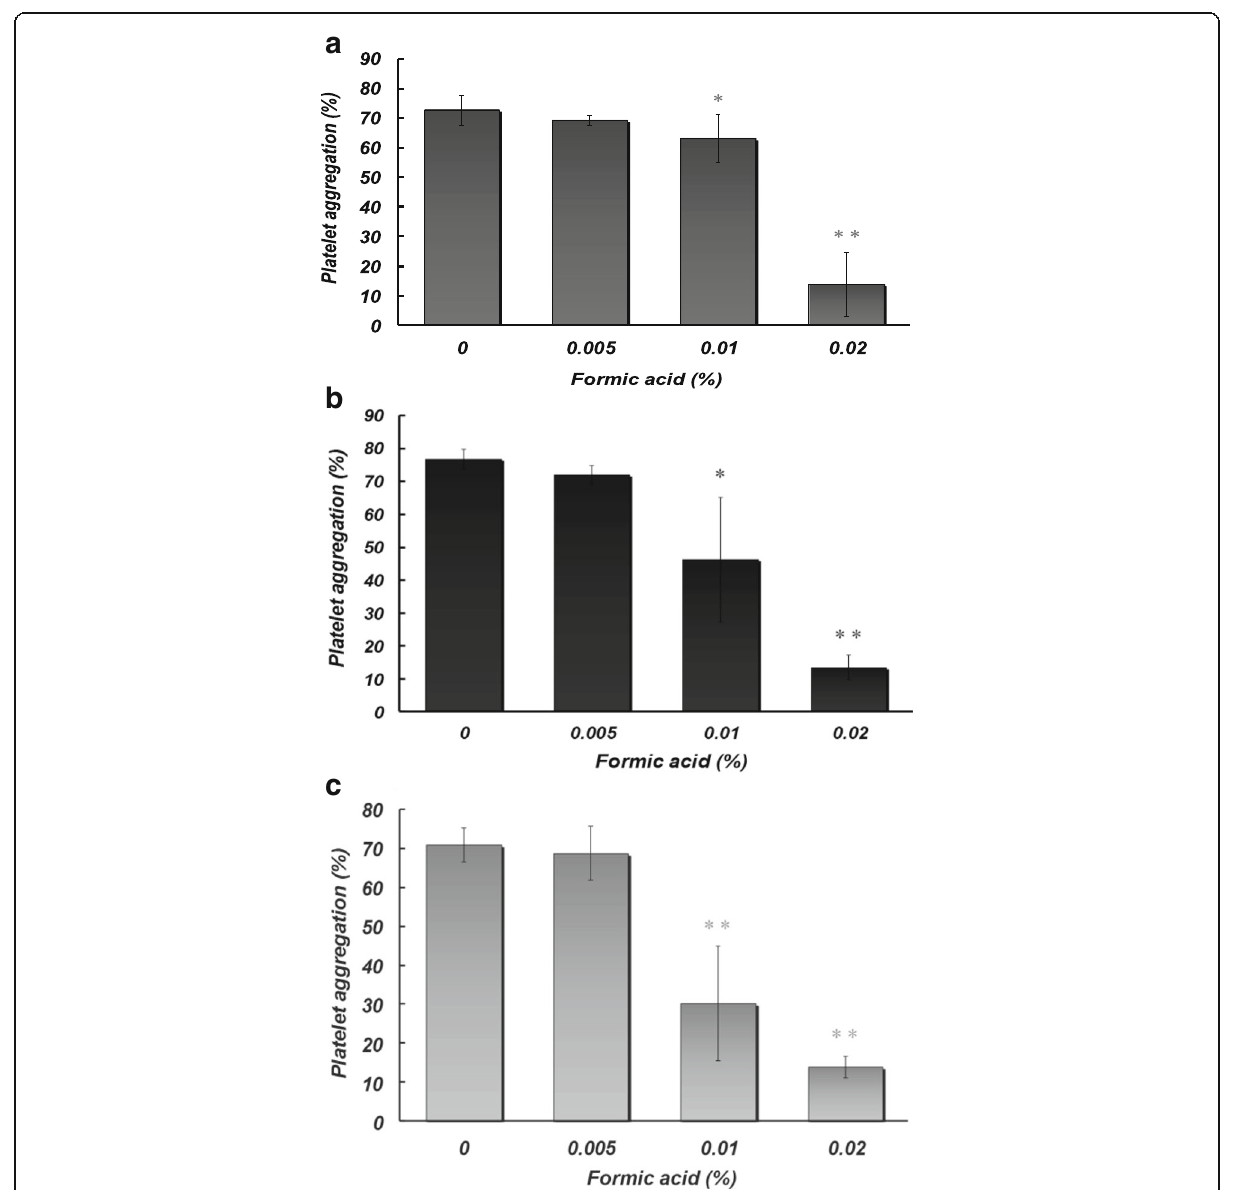
Fig. 4 Effects of pretreatment with different concentrations (0, 0.005, 0.01, and 0.02%) of formic acid on platelet aggregation (at 5 min) induced by extracellular addition of CaCl 2 (0.5 mM) in the presence of thrombin (0.025 U/ml) ( a ), thapsigargin (1 μ M) ( b ), or OAG (100 μ M) ( c ). Asterisks denote significant differences (* p < 0.05; ** p < 0.01) compared with the control. N = 4 –